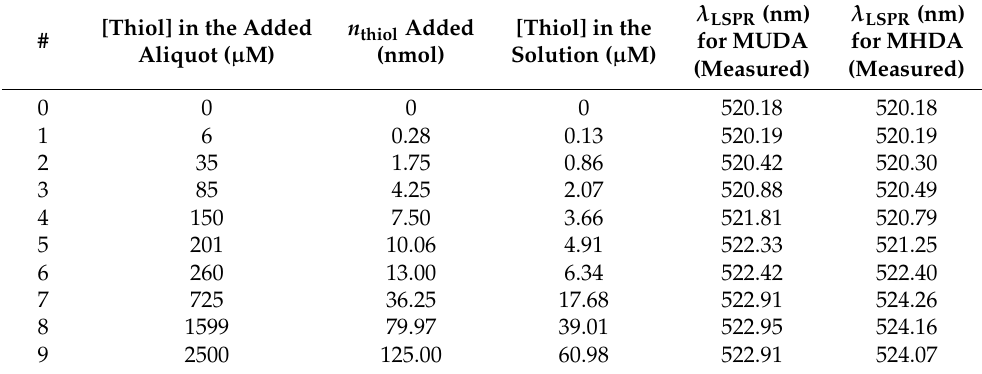
Figure 3. UV-visible spectra in solution of the progressive adsorption of ( a ) MUDA and ( b ) MHDA on 22 nm gold nanoparticles. The LSPR shift is 2.7 nm and 3.9 nm for MUDA and MHDA, respectively (see text for discussion). The insets show a zoom-in of the LSPR peak maximum. Table 1. Experimental parameters for the saturation experiment with MUDA and MHDA ( V 1 = 50 µ L) and measured LSPR peak